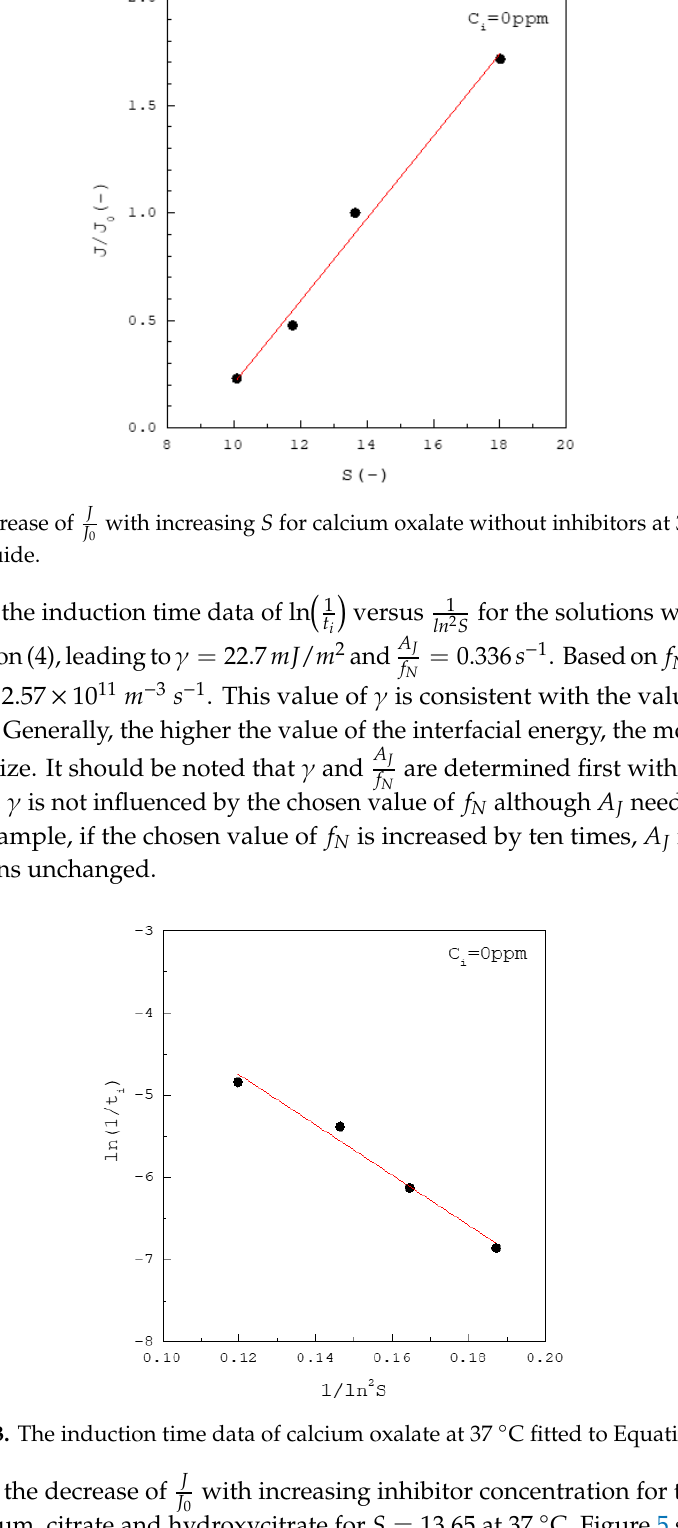
Figure 3. The induction time data of calcium oxalate at 37 °C fitted to Equation (4).